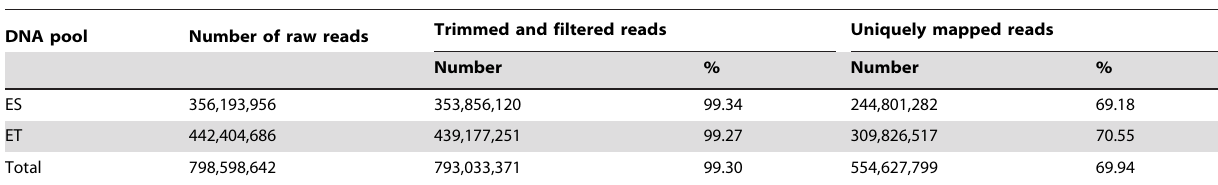
Table 1. Statistics of sequencing results.